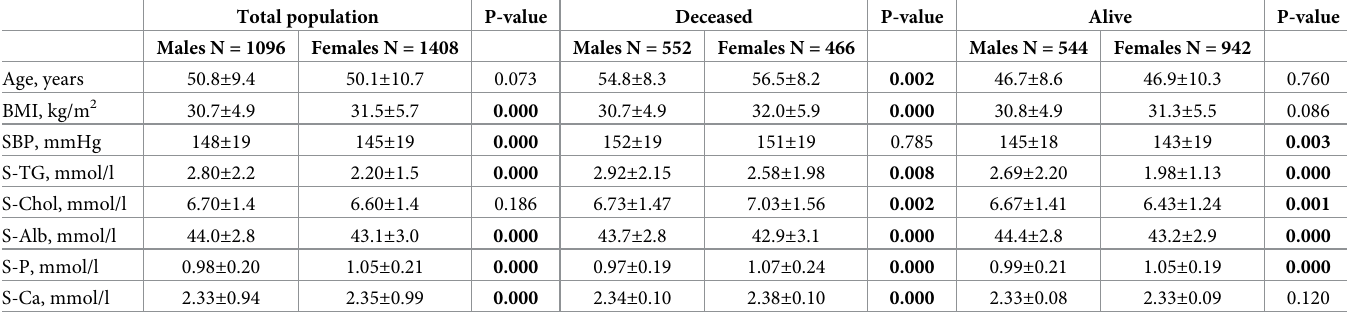
Table 1. Risk factors at baseline (mean ± sd) for total, deceased and alive male and female patients at 28 th of August 2014.